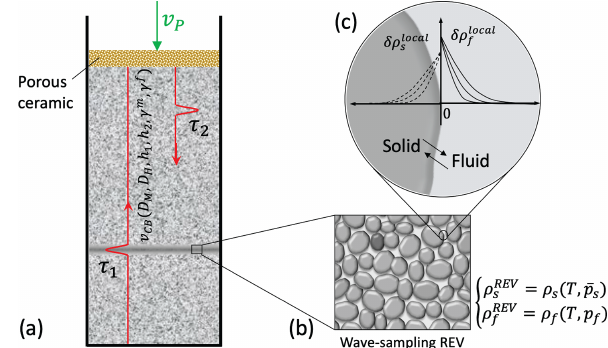
Figure 4. Experimental set-up for crushing a granular strain-rate weakening medium. (a) The problem is here formulated in analogy to the Terzaghi consolidation problem, where a pore-filling fluid is diffusing out of the compacting region and crushed grains (solids) are replacing the collapsed pores. (b, c) The non-local mesoscale process sampled by a wave-scale representative elementary volume (REV). The cross-diffusion of the solid into the fluid phase leads to an increase in density, and hence an increase in fluid pressure through the equation of state. The reciprocal cross-diffusion of flu- ids into the solid skeleton leads likewise to an increase in solid pres- sure assuming that the deformation of the solid is constrained. The macro-scale continuum-scale REV for a thermostatic formulation is defined in Fig.